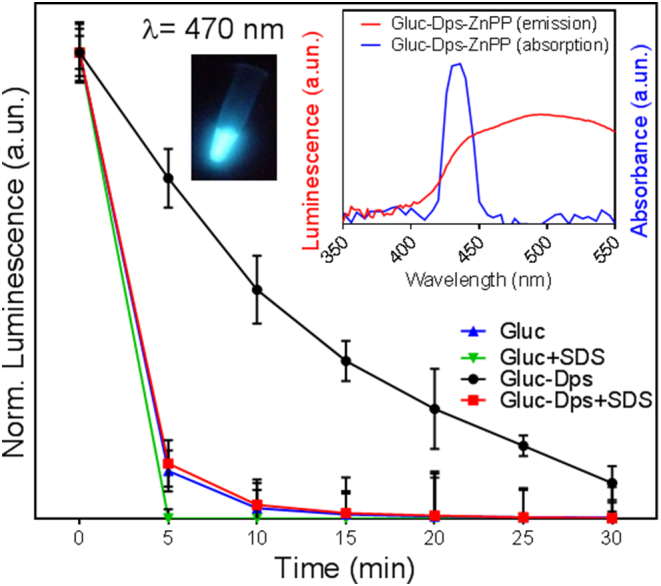
The normalized luminescence intensity measured at λ = 470 nm for Gluc-LiDps and for Gluc with and without SDS (normalized to intensity at time 0). Error bars represent average value over three independent repeats. Left inset shows a photograph of blue light emitted by the Gluc-LiDps construct. Right inset shows a spectral overlap between the bioluminescence of Gluc and absorption of ZnPP.